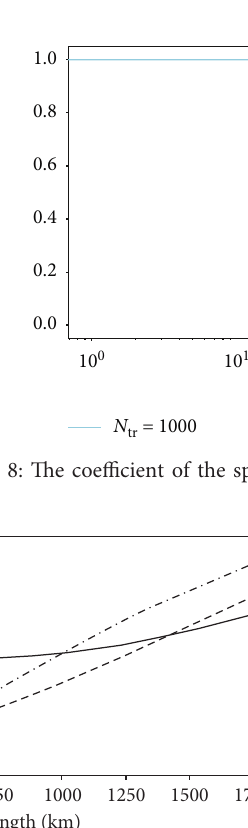
Figure 9: Relative error in the estimates of vorticity, temperature, and U -wind with different averaging